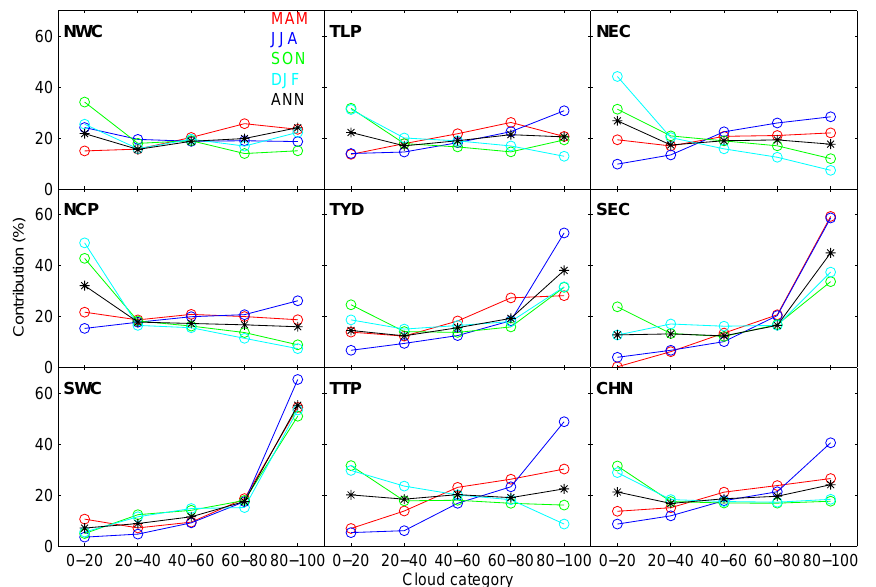
Fig. 8. Contribution of changes in diurnal temperature range for different sky conditions to the overall diurnal temperature range.